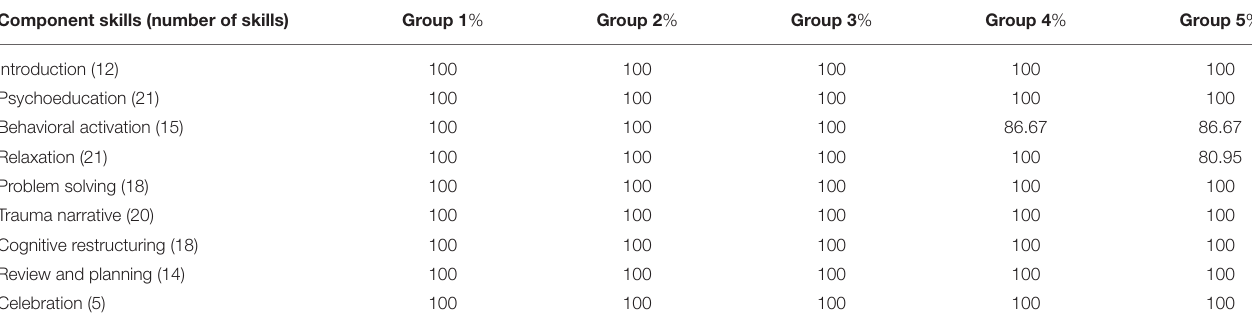
TABLE 4 | Percentage of skills completed by group leaders during group CBT sessions. Component skills (number of